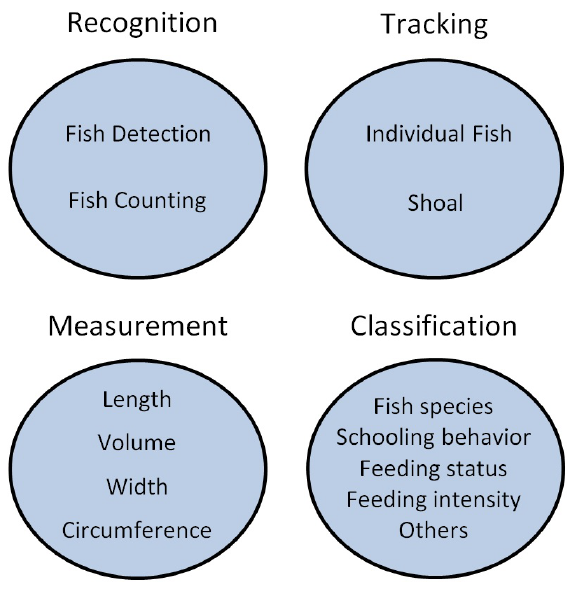
Figure 1. Categories of applications considered in this work. Applications that involve the detection and analysis of objects other than fish (e.g., food pellets) were not considered. This categorization is one among several possible options and was chosen as the best fit for the purposes of this